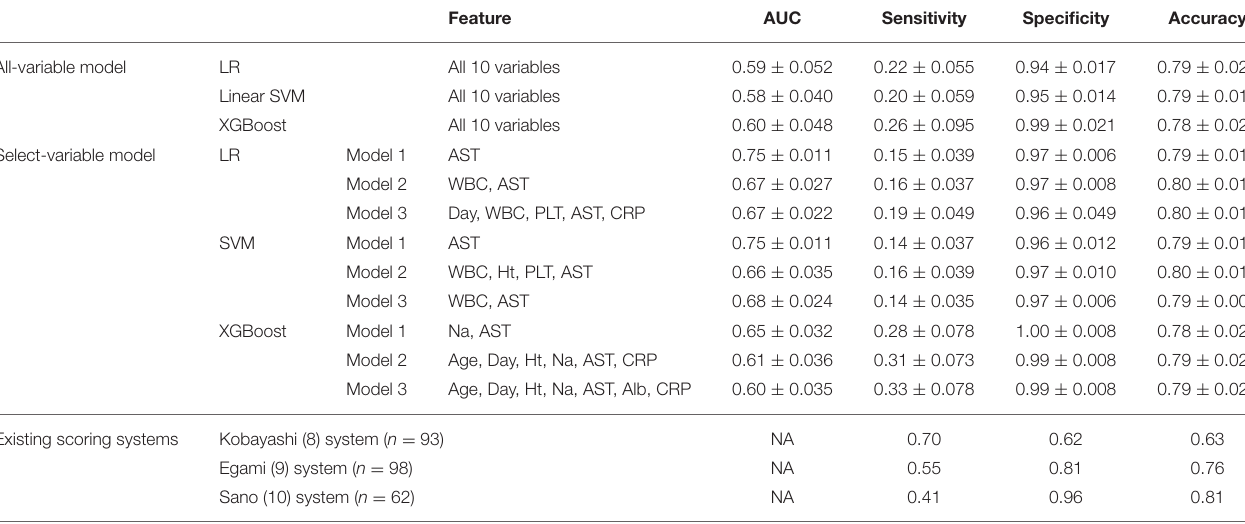
TABLE 2 | Prediction performances of the three machine learning models and existing scoring